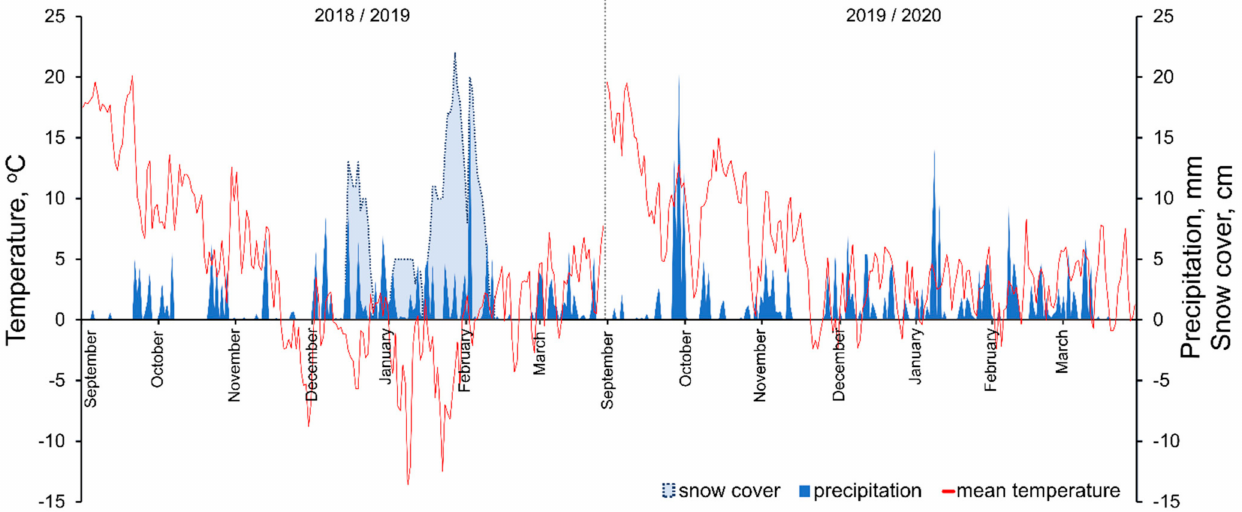
Figure 1. Meteorological conditions during autumn, winter and spring of 2018–2020. Blue covered area indicates precipitation and red solid line shows mean daily air temperature. Snow cover is represented as a light blue